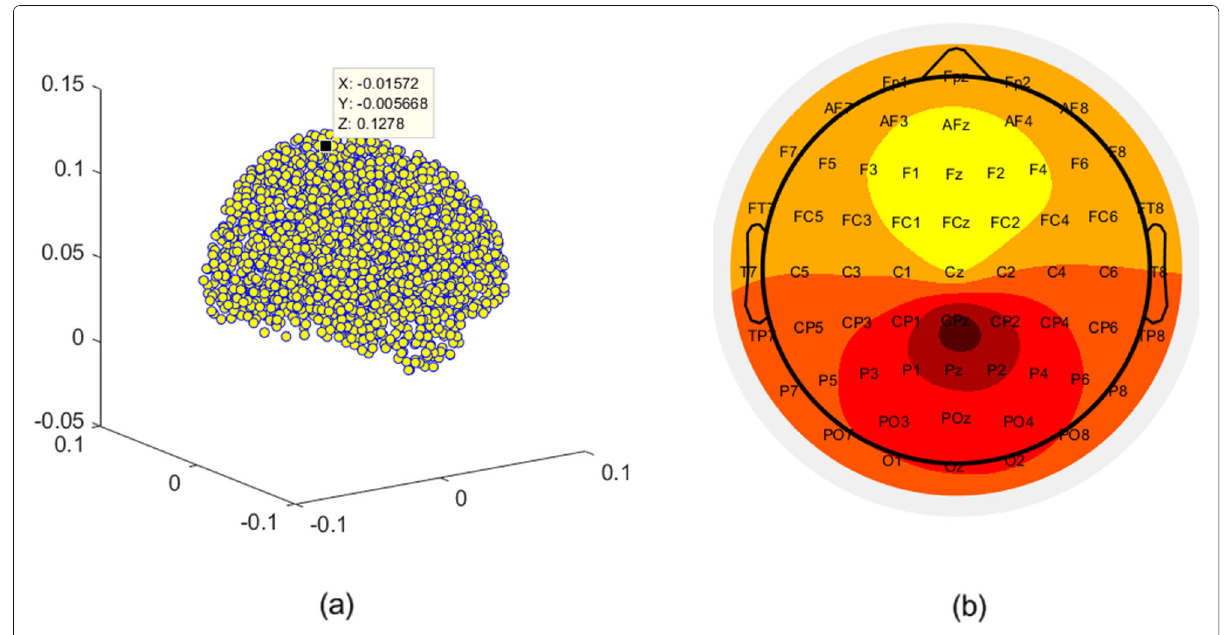
Fig. 1 The 637th dipole location, signal dipole projection with orientation according to X